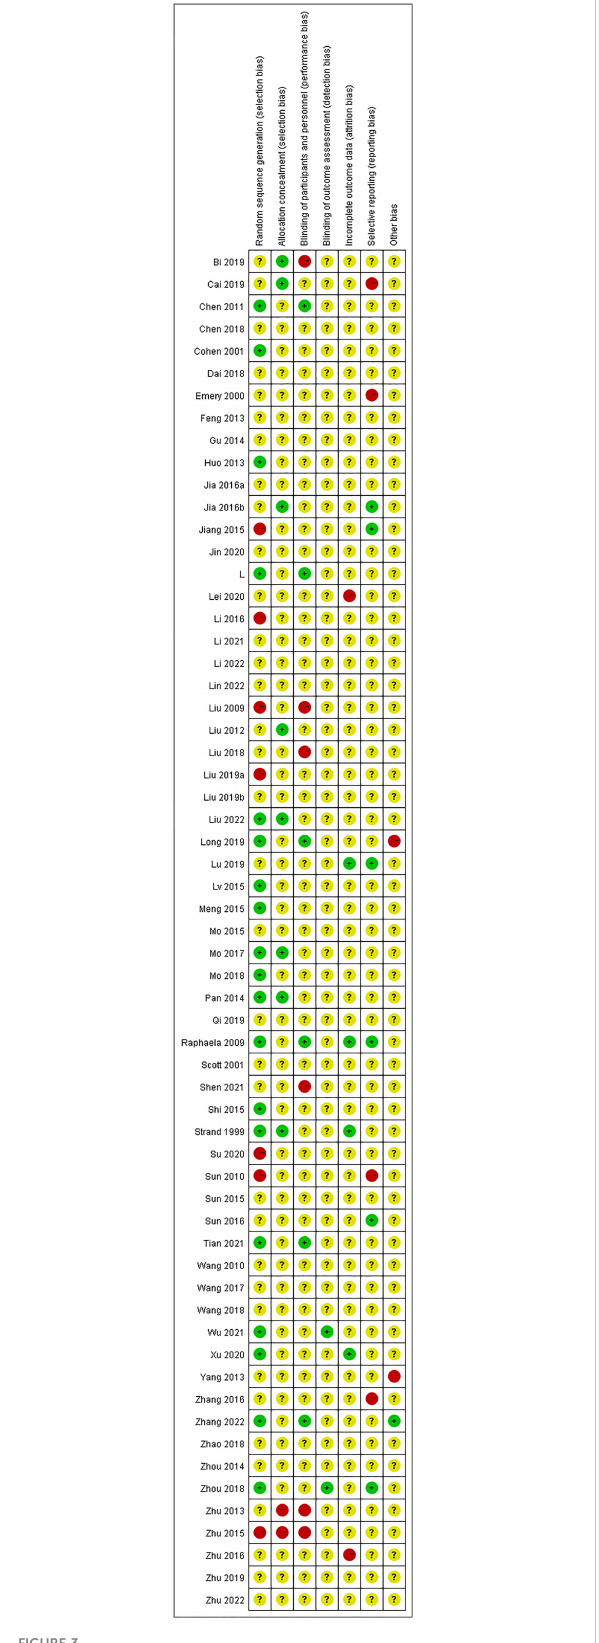
FIGURE 3 Risk of bias graph: each risk of bias item for each included